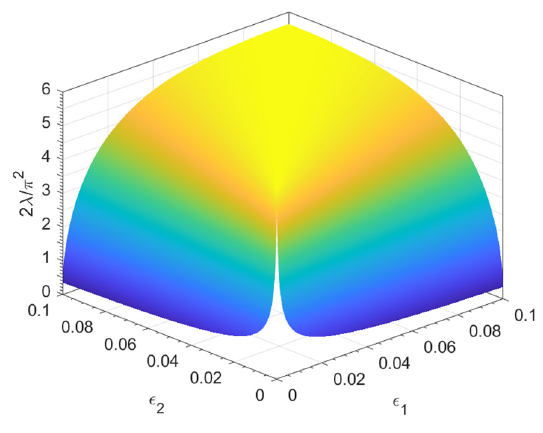
with changing ε 1 and ε 2 . π 4